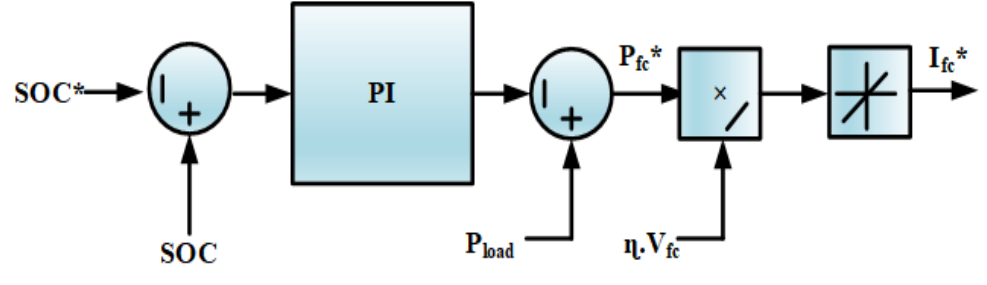
Figure 2. Classical PI control method. Table 4. Power management design requirements. Requirements of Power Management